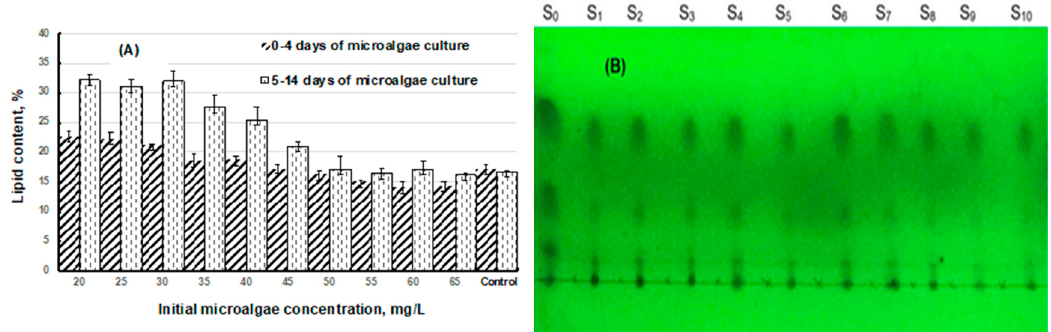
Figure 3. Lipid production in two phases of Chlorella vulgaris cultivation: exponential phase (0–4 days) and death phase (5–14 days); ( A ) Lipid concentration of microalgae measured in each sample, ( B ) TLC plate of lipid extracted; S 0 is the sample of green bean standard, S 1 to S 10 is the 1st sample to 10th sample corresponding to the TAG in lipid extract of initial microalga concentration from 20 mg·L − 1 to 65 mg·L − 1 .